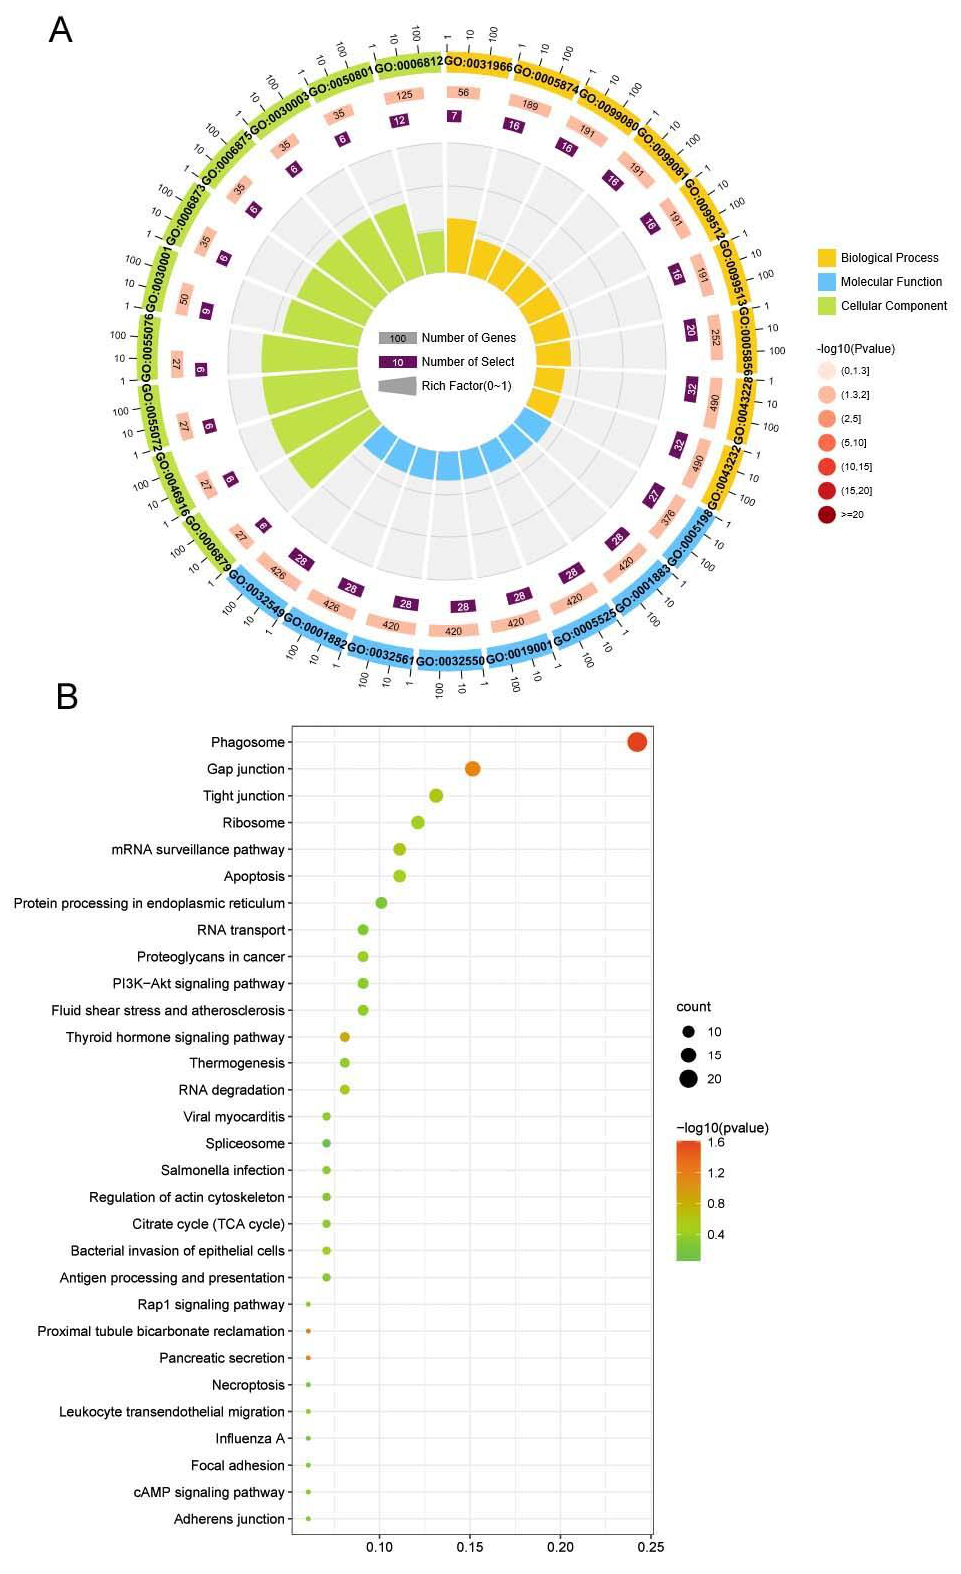
Figure 4. GO and KEGG enrichment analysis of DEGs. ( A ) The top 30 significantly enriched GO terms of DEGs. ( B ) The top 30 enriched KEGG pathways of DEGs.